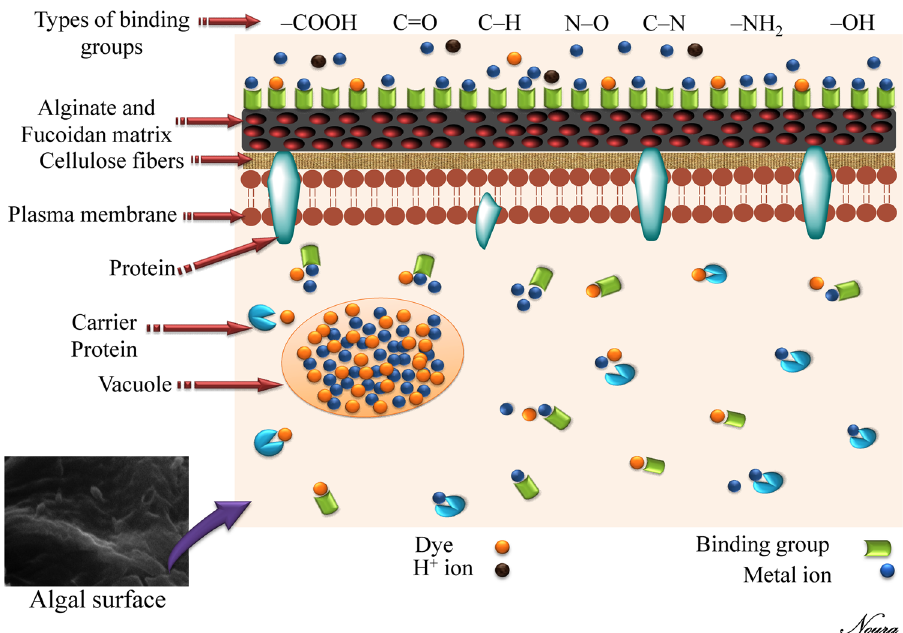
Figure 7. Biosorption mechanism of metal and dye by algal